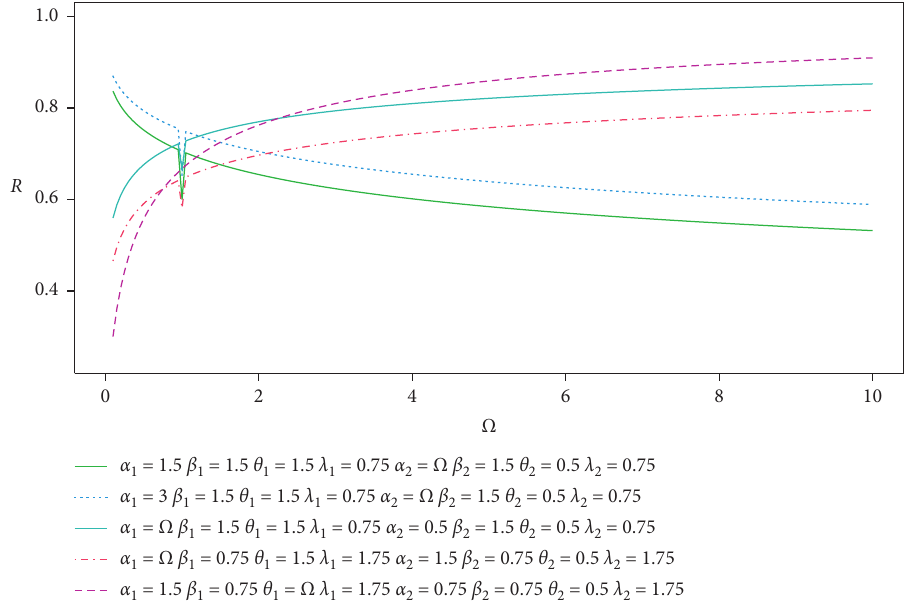
Figure 4: The stress-strength reliability measure for